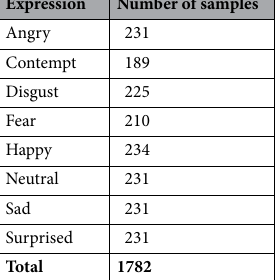
Table 1. Counts of each facial expression in the IRDatabase . Bold value indicates total number of samples used in the